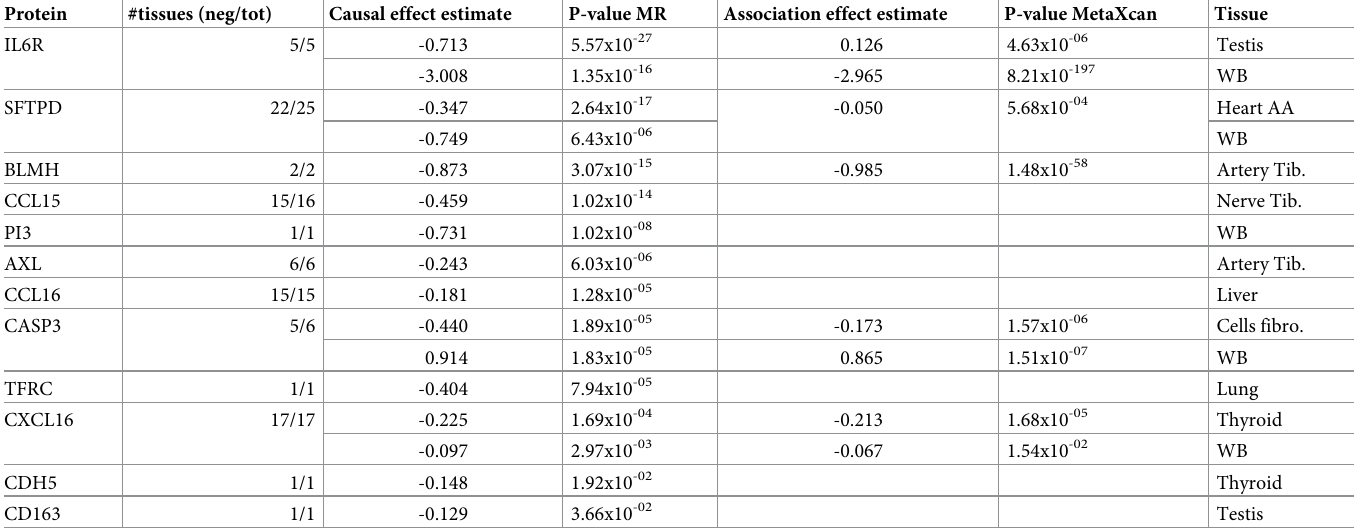
Table 4. Proteins with predominantly negative causal links of GE and